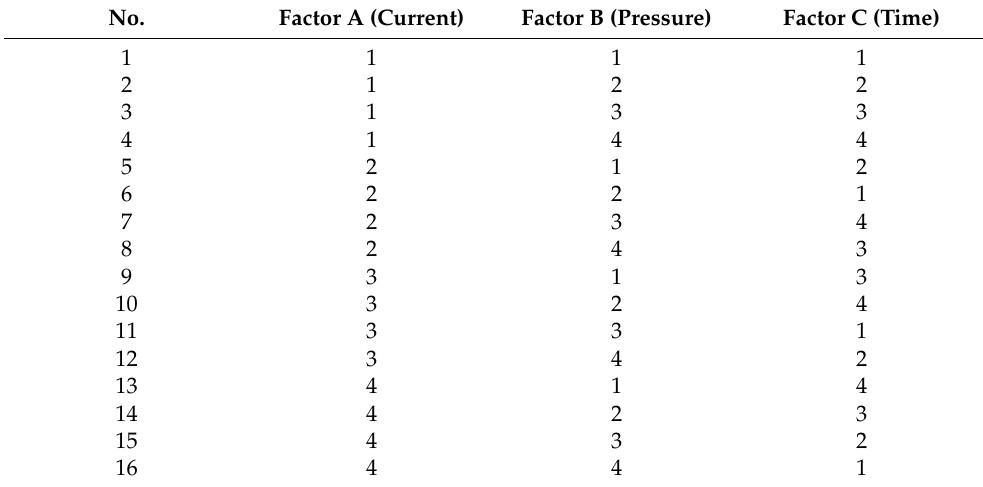
Table 3. Standard orthogonal table.